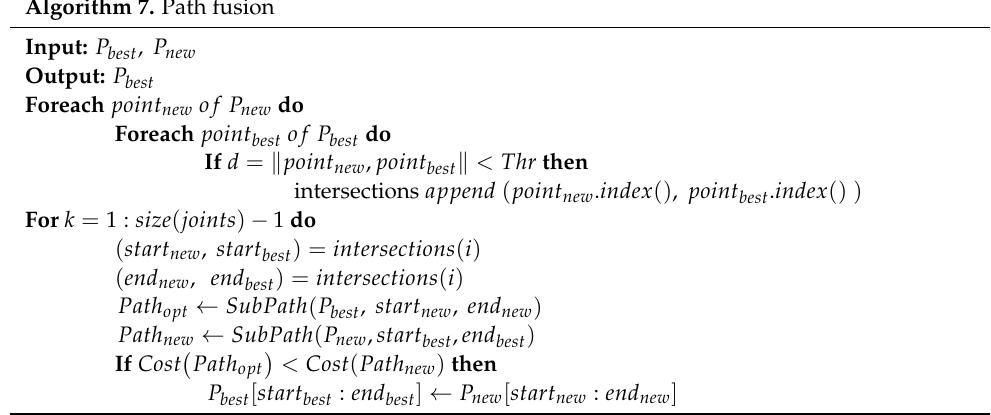
Figure 7. Schematic illustration of the path fusion process. The green path path obest is the currently obtained optimal path, the blue path path new is the newly obtained feasible path, and q near is the intersection of the two paths. Algorithm 7. Path